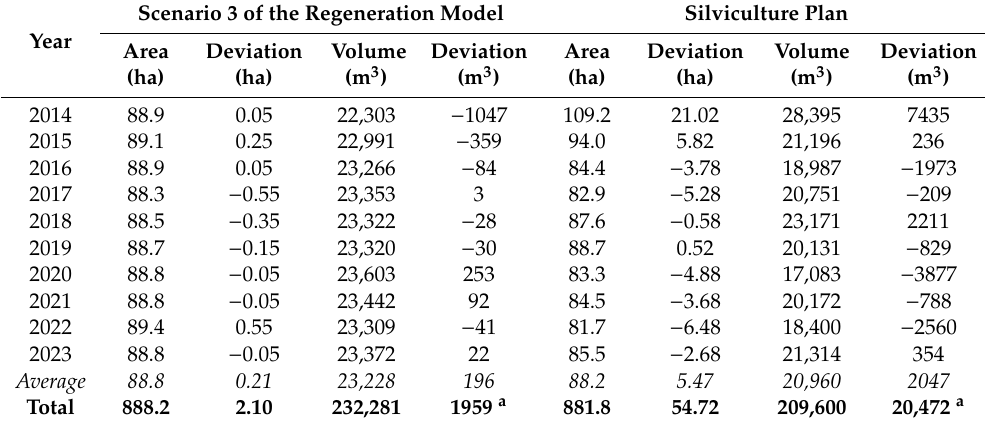
Table 10. Comparison of the results of scenario 3 of the regeneration model and the silviculture